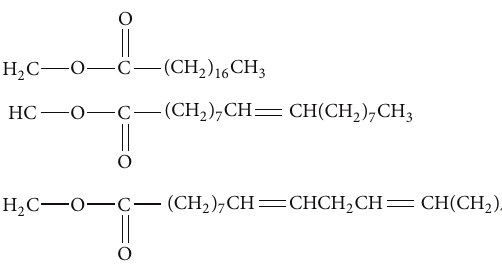
Figure 1: Structure of typical triacylglycerols